Question: Express in one sentence what the figure is showing.
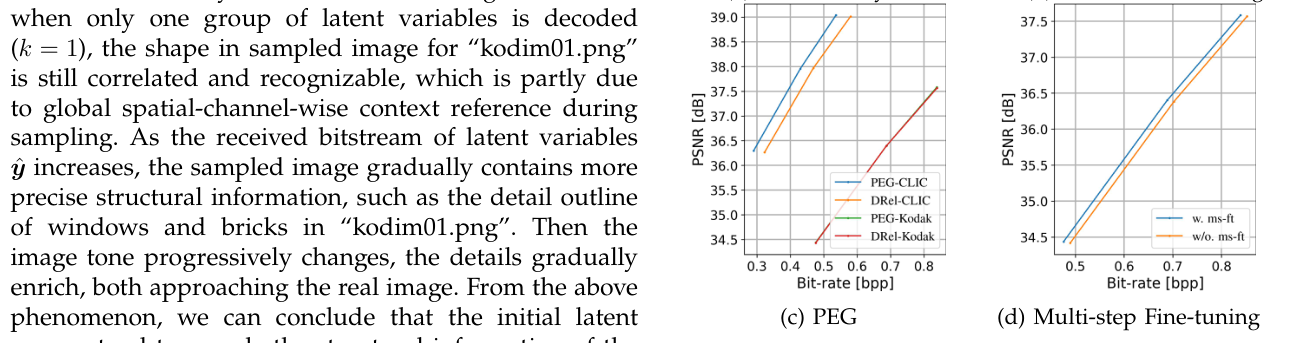
Answer: Comparative study of token-Mixer order, au- toregression order, position embedding, and multi-step fine-tuning. In this table, “i-c” vs. “c-i” represent inner- group vs. cross-group token-mixer orders. “sfo” (spatial- first-order) and “cfo” (channel-first-order) refer to differ- ent autoregression orders. “Rel”, “Abs” and “DRel” is relative, absolute and diamond-shape relative position embedding. “ms-ft” stands for multi-step fine-tuning.